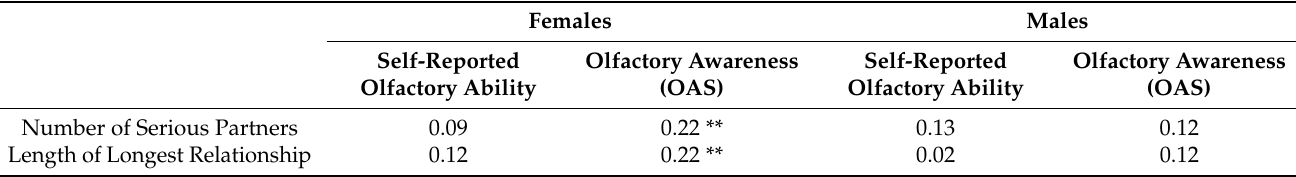
Table 4. Correlations Between Olfaction and Relationship Measures by